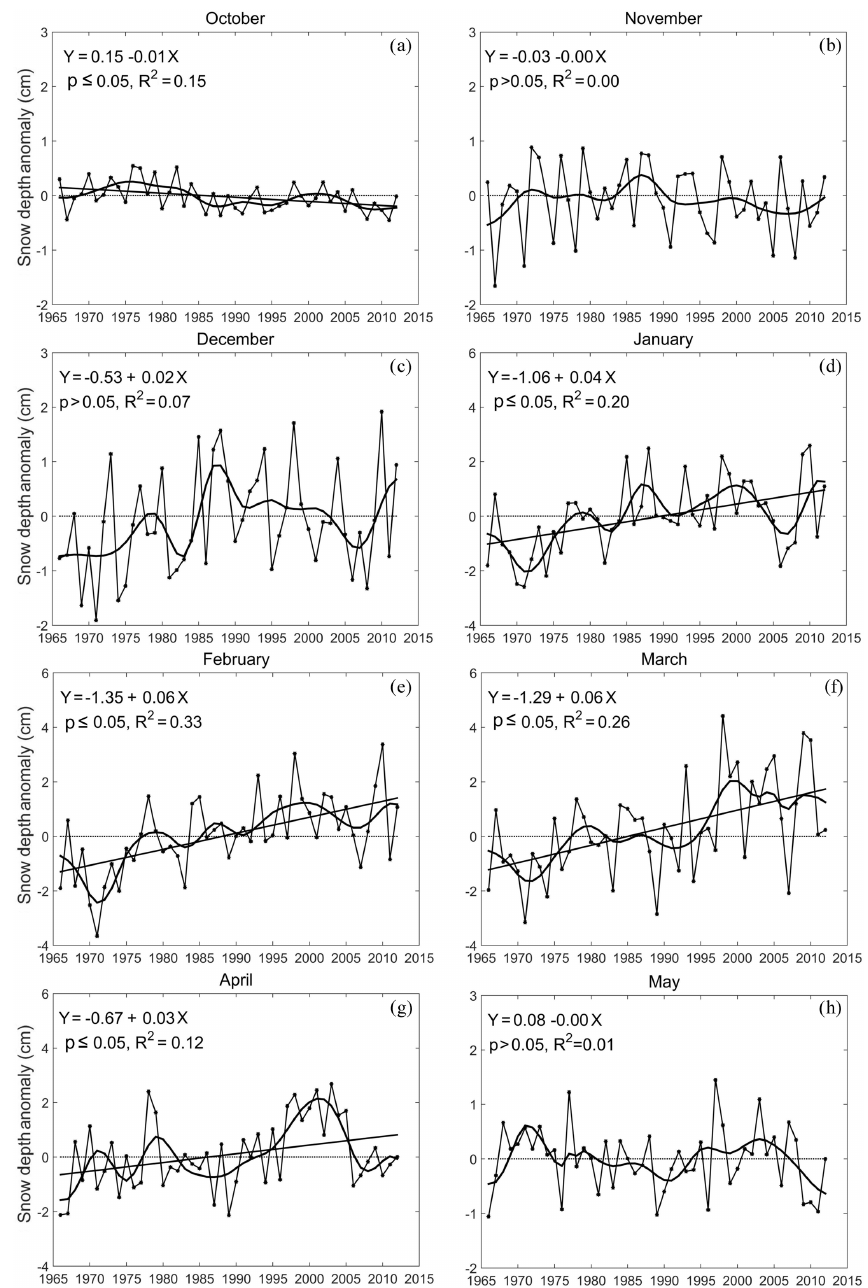
Figure 5. Composites of the anomalies of monthly mean snow depth (from October to May) from 1966 through 2012 with respect to the 1971–2000 mean across the Eurasian continent. The composite anomaly was calculated by the sum of anomalies from all stations divided by the number of stations at a given year. (a) October. (b) November. (c) December. (d) January. (e) February. (f) March. (g) April. (h) May. The line with dots is the anomaly of monthly mean snow depth. The thick curve represents the smoothed curve using wavelet analysis. The thick line presents a linear regression trend. Linear regression trend is only shown when the rate of change at the 95%